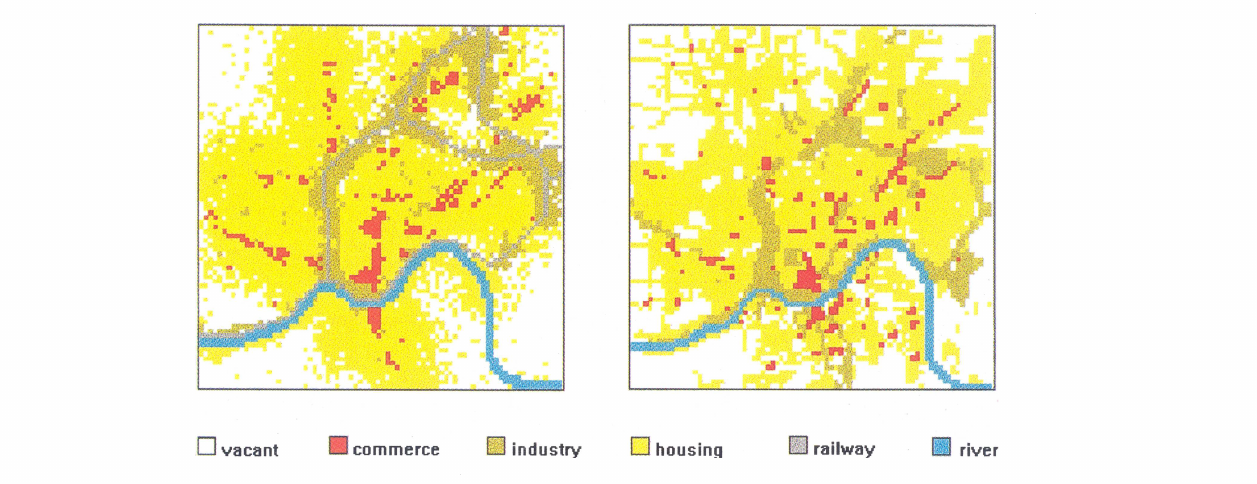
FIGURE 2 Simulation of Cincinnati (left) and actual land use (simplified), 1960 (right); the road system used in the simulation is not shown. See Colour Plate